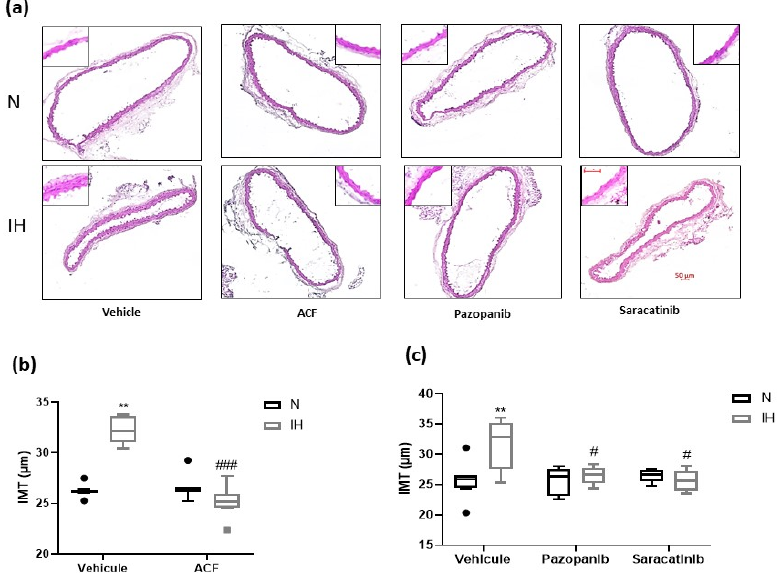
Figure 3. The effect of the inhibition of VE-cadherin cleavage pathways on intima-media thickness in C57BL/6J mice. ( a ) Representative images of aortic cross-sections stained with Hematoxylin-Eosin. ( b ) Inhibiting HIF-1 (by ACF) prevented the IH-induced elevation of IMT in C57BL/6J mice exposed to IH for 14 days, compared to N (Kruskal-Wallis test, ** p < 0.01 vs. N + vehicle, ### p < 0.001 vs. IH + vehicle, n = 7–8). ( c ) Inhibiting VEGFR tyr-kinases (by pazopanib) and src-kinases (by saracatinib) prevented the IH-induced elevation of IMT in C57BL/6J mice exposed 14 days to IH, compared to N (Kruskal-Wallis test, ** p < 0.01 vs. N + vehicle, # p < 0.05 vs. IH + vehicle, n = 5–8). (N: normoxia, IH: intermittent hypoxia. Values are median + Interquartile range. Scale bars = 50 µm.